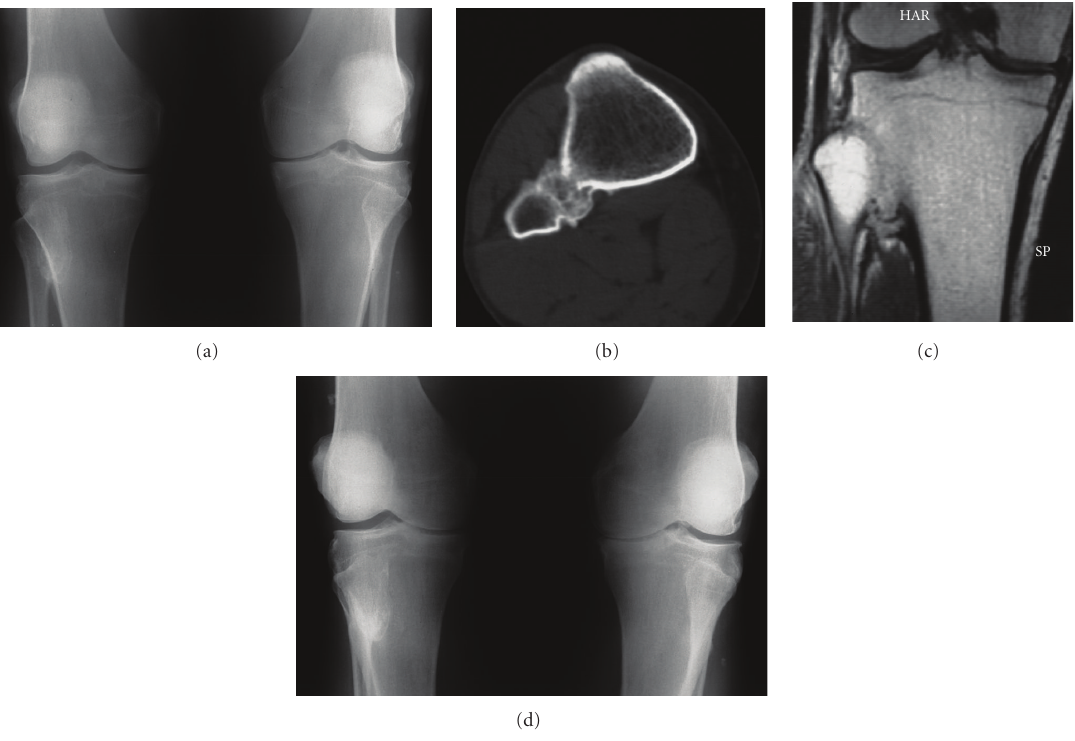
Figure 1: AP radiograph of both knees (a), CT (b), and MRI (c) examination, in a 55-year-old man, indicating synostosis of the proximal TFJ of the right knee initially, and 4 years later (d).